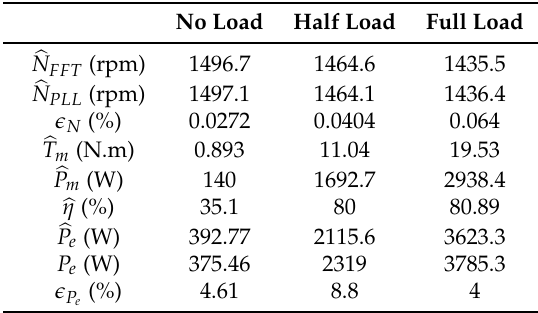
Table 5. Experimental test at constant speed, nominal values: N N = 1435 rpm, Pm N = 3000 W,